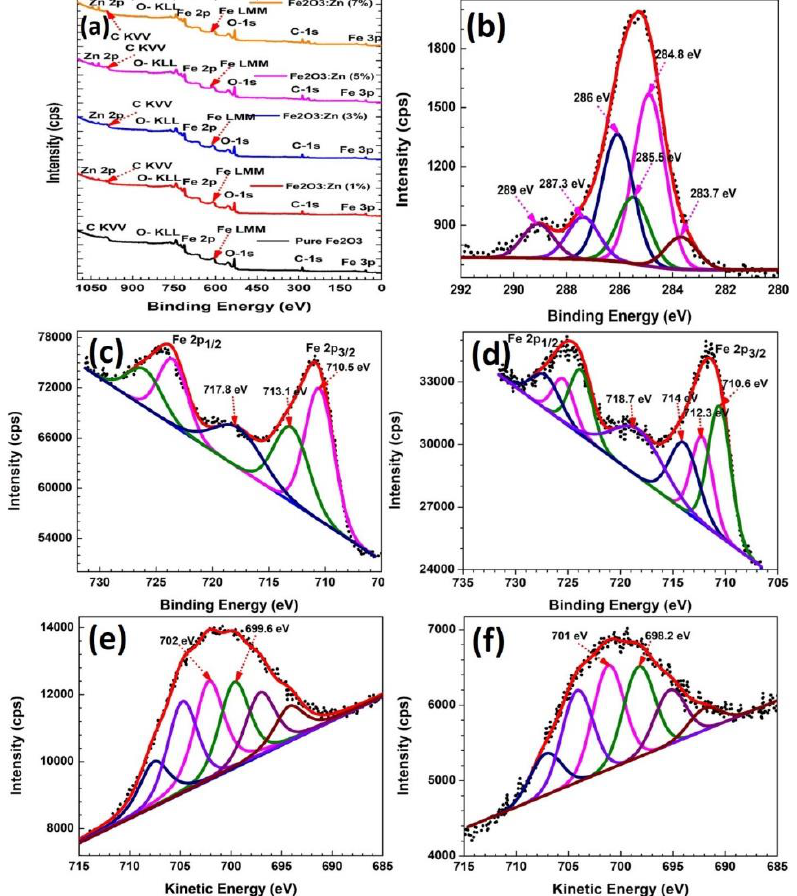
Figure 5. XPS spectra: ( a ) general surveys; ( b ) C − 1s; ( c ) Fe 2p for pure Fe 2 O 3 sample; ( d ) Fe2p for Fe 2 O 3 doped with Zn (7%); ( e ) FeLMM peak of pure Fe2O3; and ( f ) FeLMM for Fe 2 O 3 doped with Zn